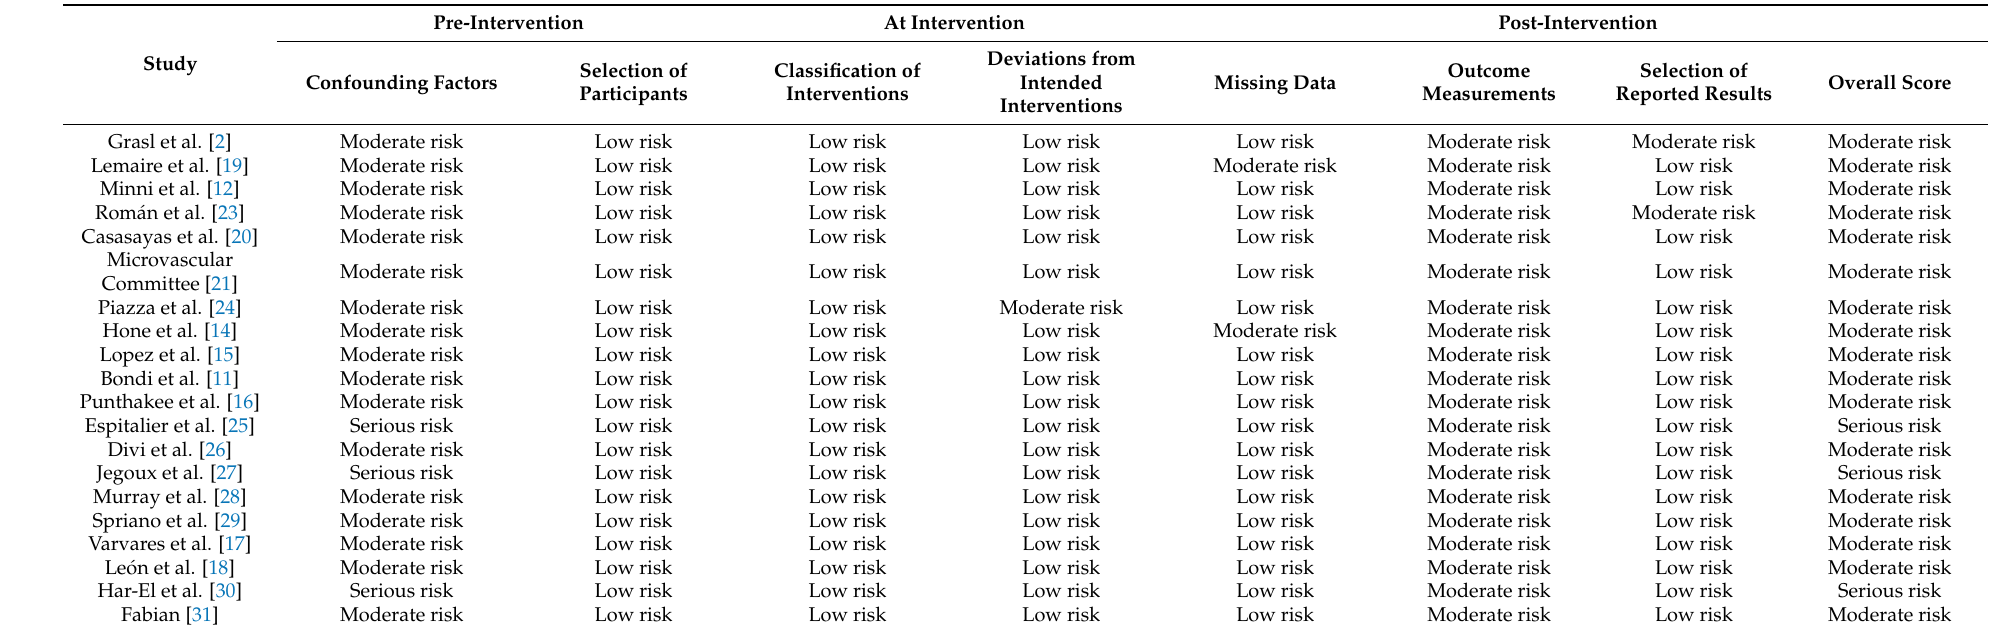
Table 4. Quality of included